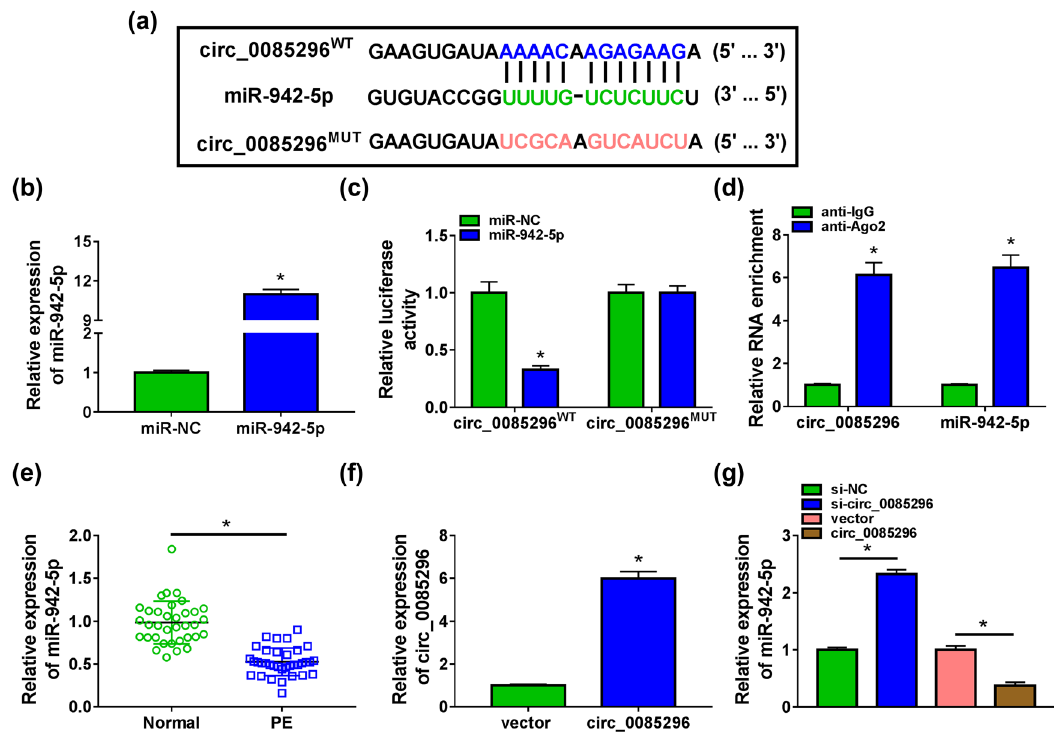
Figure 3: circ_0085296 sponged miR - 942 - 5p. ( a ) The sequences of circ_0085296 WT/MUT vectors are shown. ( b ) The miR - 942 - 5p expression was measured by qRT - PCR to assess the transfection e ffi ciency of miR - 942 - 5p mimic. Dual - luciferase reporter assay ( c ) and RIP assay ( d ) were performed to con fi rm the interaction between circ_0085296 and miR - 942 - 5p. ( e ) The expression of miR - 942 - 5p was examined by qRT - PCR in the placental tissues of PE patients and normal pregnant women. ( f ) The circ_0085296 expression was measured by qRT - PCR to evaluate the transfection e ffi ciency of circ_0085296 overexpression vector. ( g ) QRT - PCR was used to detect miR - 942 - 5p expression in HTR - 8/SVneo cells transfected with si - circ_0085296 or circ_0085296 overexpression vector. * P <